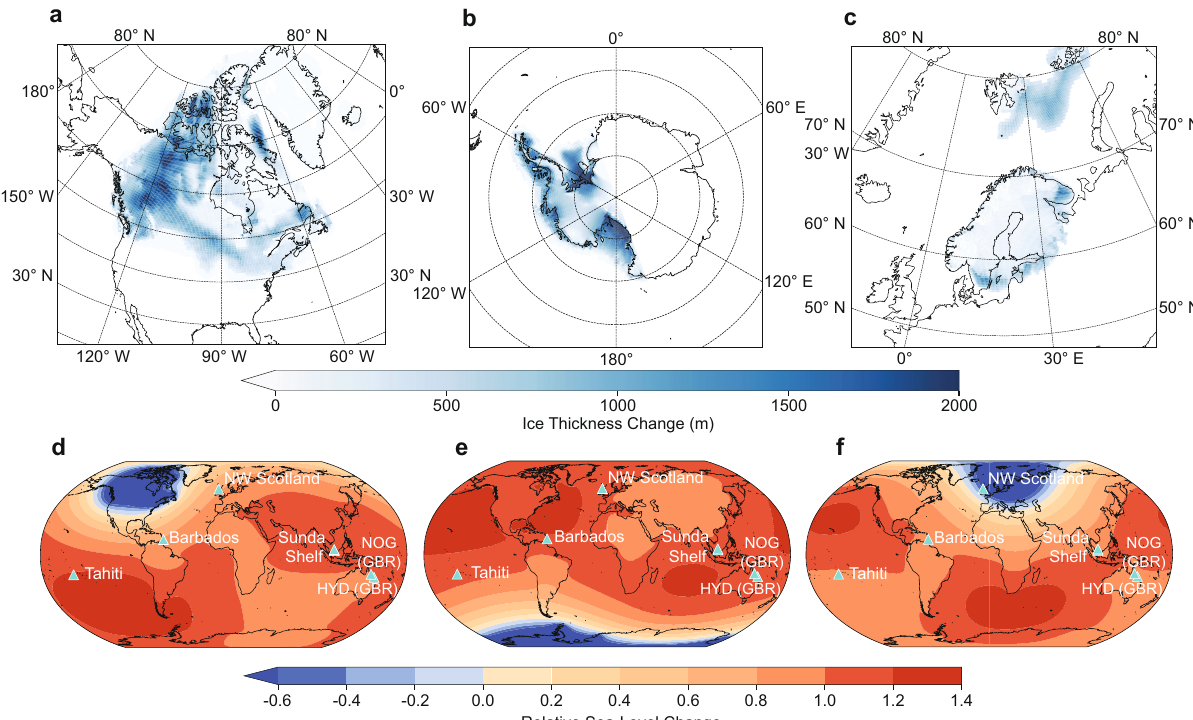
Fig. 1 Ice melt geometries and normalised sea-level fi ngerprints used in this study. a – c Ice mass loss pattern for the NAIS, AIS and SIS, which were used to generate sea-level fi ngerprints shown in ( d – f ) that represent elastic-induced global relative sea-level change corresponding to one unit of ice mass loss from each ice sheet. a , c The reconstructed MWP-1A ice melt geometries from Lambeck et al. 24 and BRITICE-CHRONO 52 . b The LGM-to-present West AIS melt geometry from Whitehouse et al. 54 (see Methods for details). The cyan triangles and text denote the location and name of each sea-level site. HYD = Hydrographer ’ s Passage, NOG = Noggin Pass, GBR = Great Barrier Reef, NW Scotland = Northwest